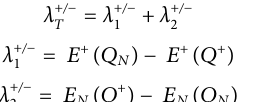
FIGURE 2 Four-point model used for the reorganization energy